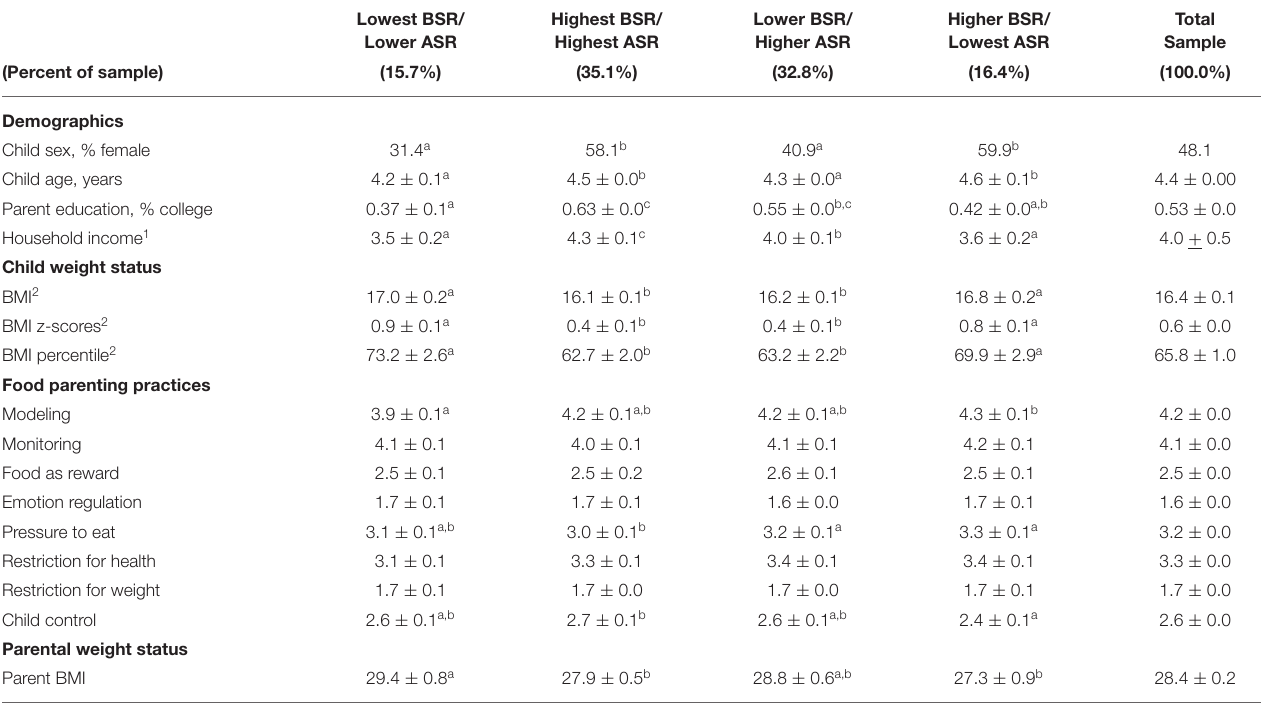
TABLE 4 | Mean ( ± standard error) distribution of behavioral self-regulation (BSR) and appetite self-regulation (ASR) indices by profile membership. Lowest BSR/ Lower